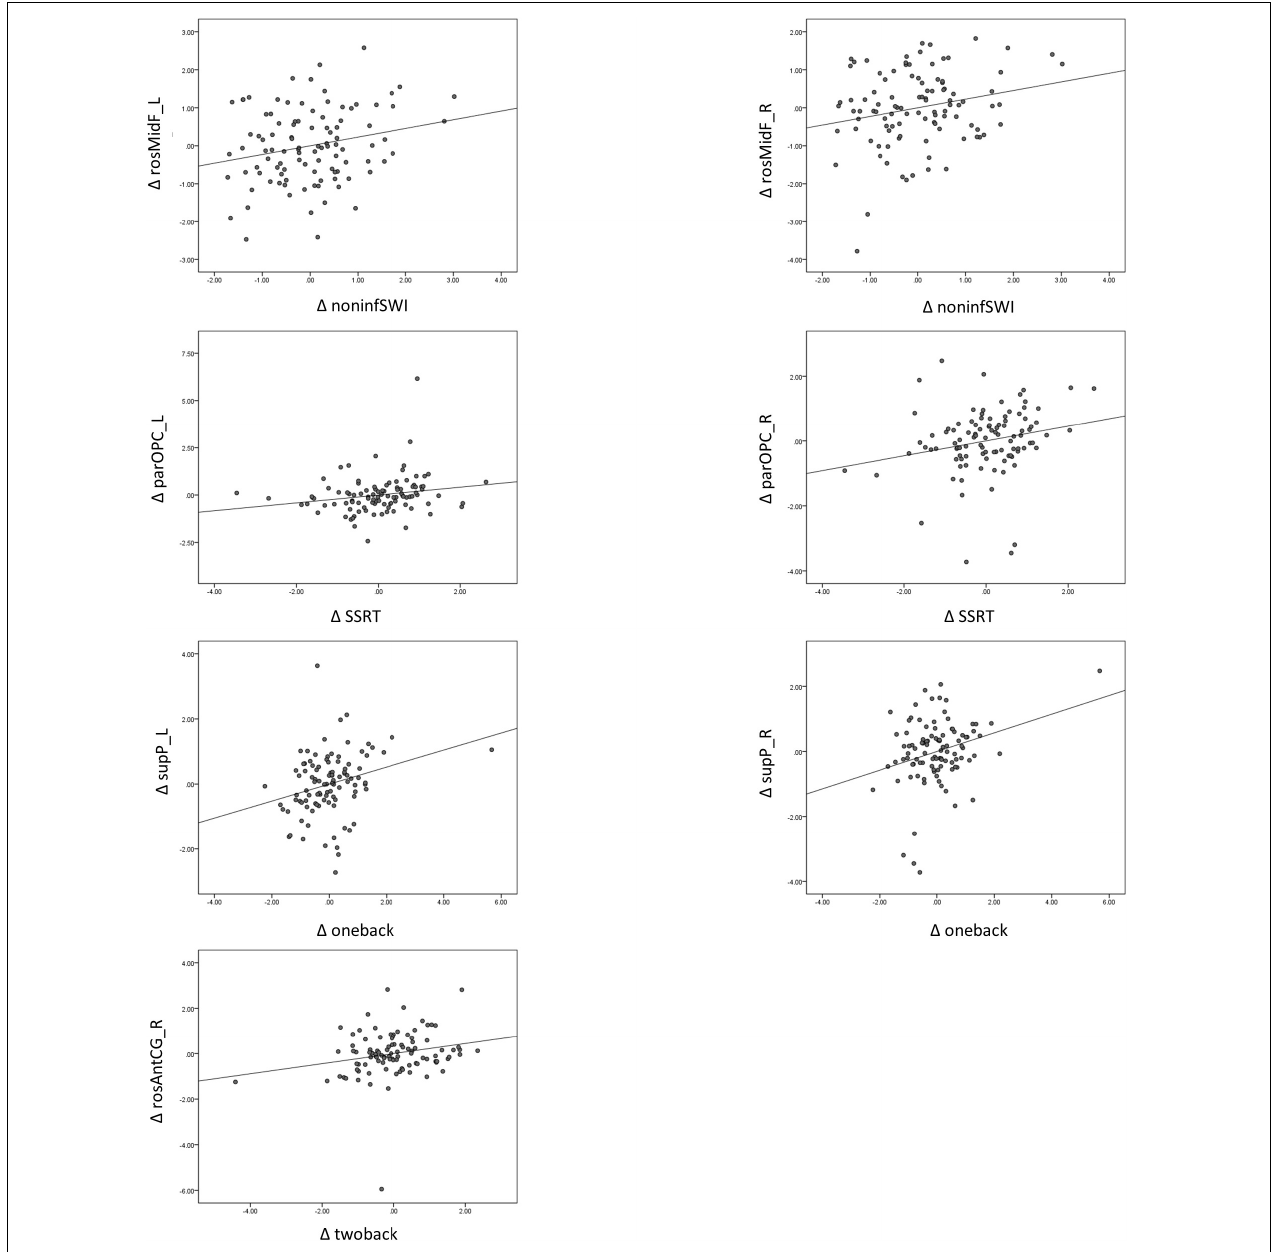
FIGURE 3 | Relationship between change in gray matter volume ( (cid:49) GMV) and change in cognitive performance ( (cid:49) Z -score), controlling for sex, education, and BDI-II score, shows changes in GMV in the parOPC and rosAntCG_R and sup_L associated with 1-back d (cid:48) , 2-back d (cid:48) , and SSRT. L, left; R, right; rosMidF, rostral middle frontal; parOPC, pars opercularis; supP, superior parietal; rosAntCG, rostral anterior